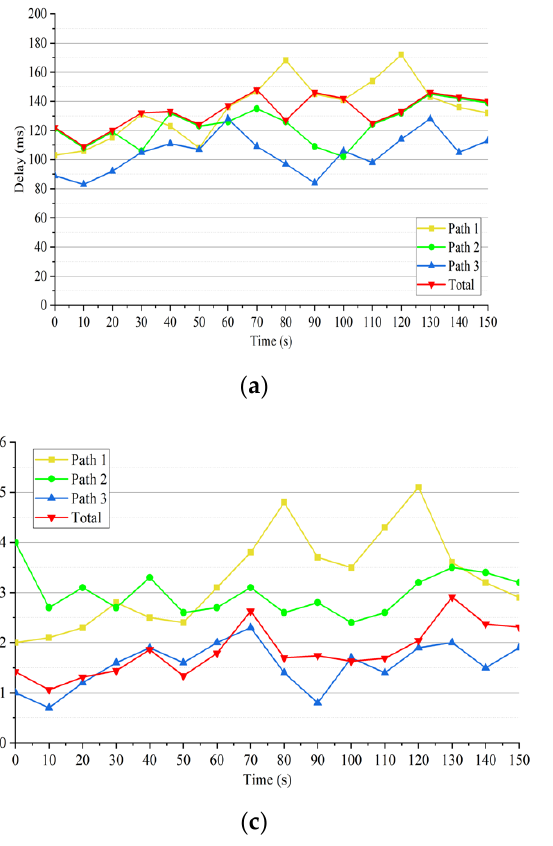
Figure 6. The test sample QoS information monitoring. ( a ) is the real-time monitoring delay of the three sub-paths and the overall service delay obtained after the adjustment of the load distribution strategy. ( b ) is the real-time monitoring jitter of the three sub-paths and the overall service jitter obtained after the adjustment of the load distribution. ( c ) is the real-time monitoring packet loss of the three sub-paths and the overall service packet loss obtained after the adjustment of the load distribution